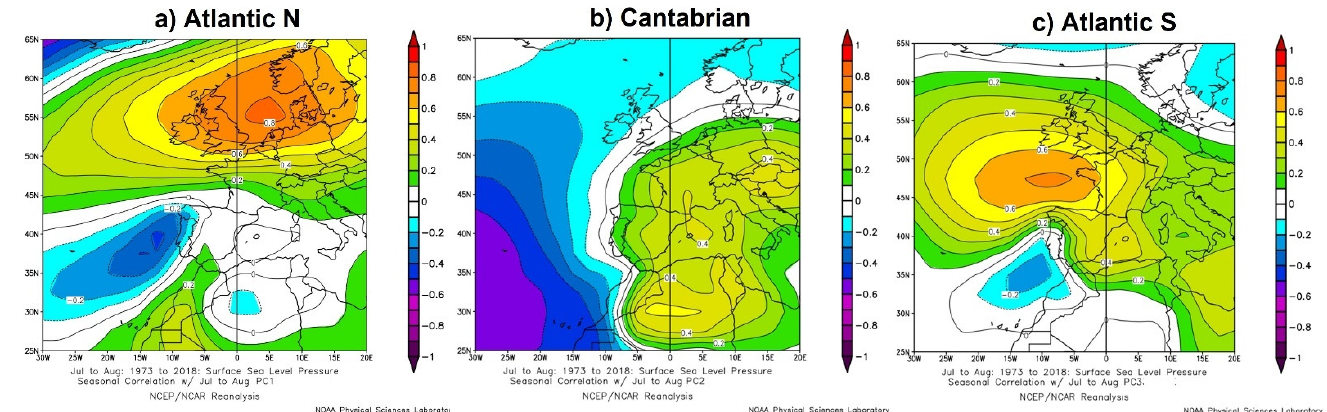
Figure 6. Correlation maps between times series of the Principal Component scores for the ( a ) Atlantic N region ( b ) Cantabrian Region ( c ) Atlantic S region and sea level pressure fields. Values higher (lower) than 0.31 ( − 0.31) are signi fi cant at the 95% significance level, according to a t -test. Images provided by the NOAA/ESRL Physical Sciences Laboratory, Boulder Colorado from their Web site at http://psl.noaa.gov/, accessed on m 31 August 2021).